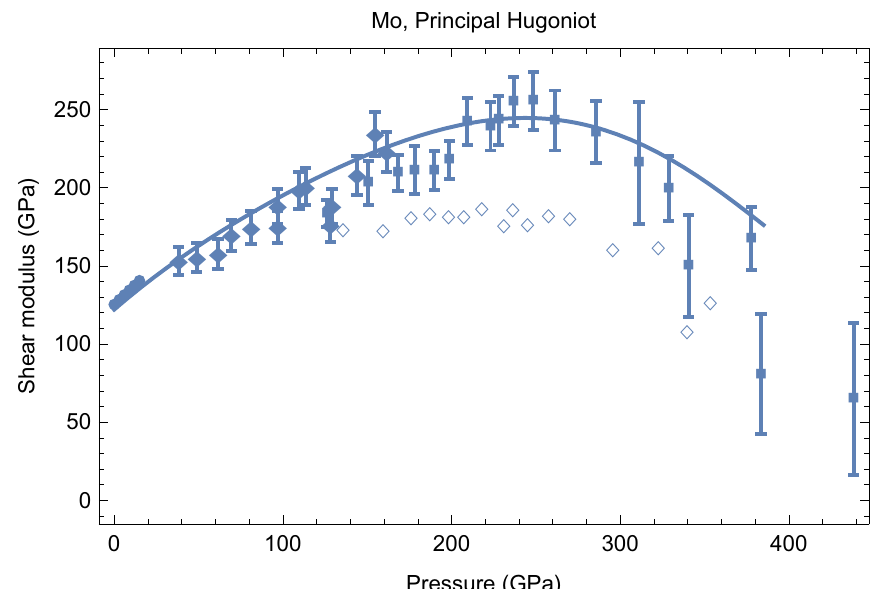
Figure 2. The shear modulus of bcc-Mo along the principal Hugoniot. The experimental data are from Reference [24]; different symbols coincide with those in Figure 2 of [24]. Above ∼ 390 GPa G effectively drops down to zero, which implies that melting has occured at this pressure. The results of Lukinov et al. [16] are shown as open diamonds.